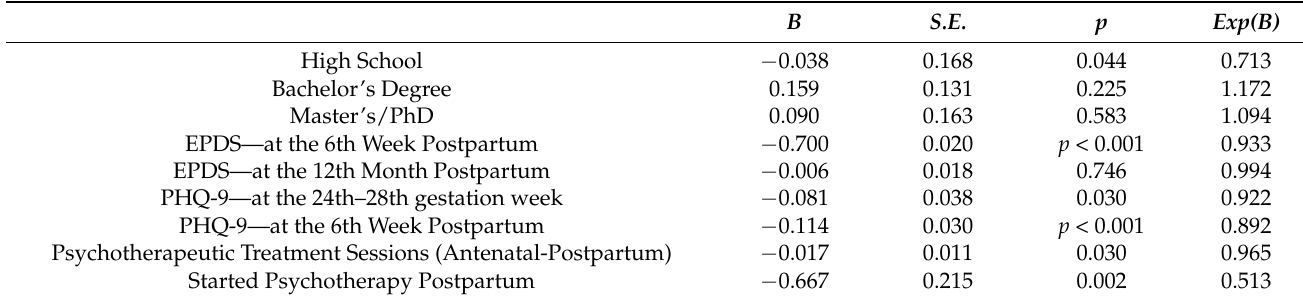
Table 3. Logistic regression analysis model with exclusive breastfeeding at the end of the 6th month postpartum as the dependent